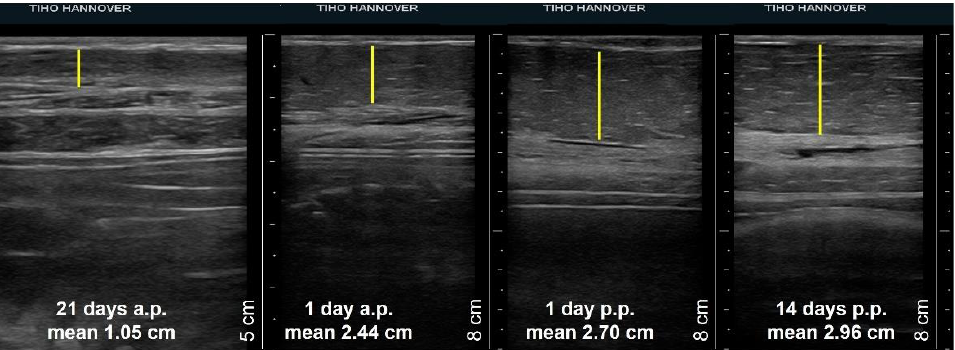
Figure 4. Four sonograms of a sow´s third mammary gland showing the thickness of the parenchyma (yellow line) at day 21 a.p., day 1 a.p., day 1 p.p., day 14 p.p. Mean values represent the mean thickness of the gland parenchyma of all sows during the specific day of pregnancy or lactation.